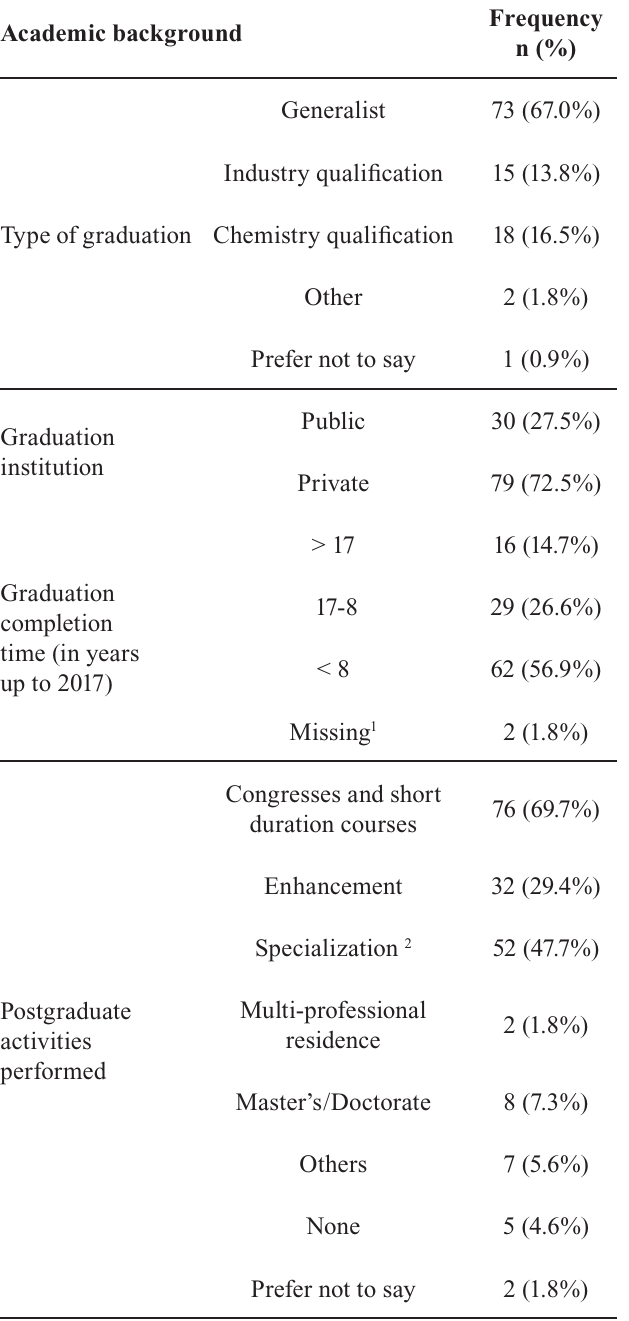
TABLE I - G eneral profile and academic background of pharmacists in charge of community pharmacies in the metropolitan region of Belo Horizonte-MG (n = 109; 2017)